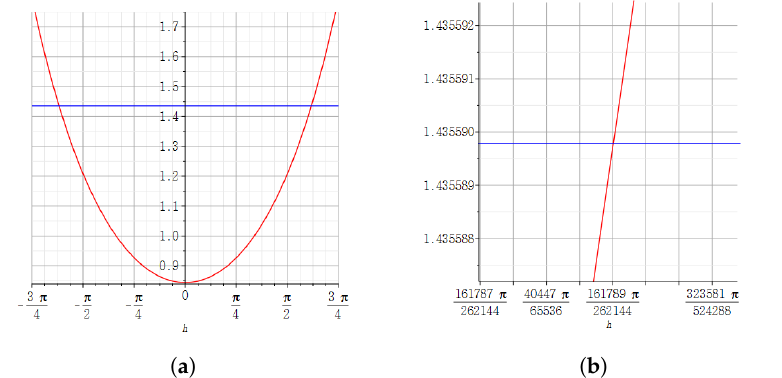
Figure 3. ( a ) Graph showing the absolute value of the quaternion j -step derivative of cos ( z ) at z 0 according to the step size h driven by the Maple program. ( b ) In the graph of ( a ), the result of zooming in about h near 5 π . In ( a , b ), the red graph represents the j -step derivative of cos z at z 0 8 according to the size of h , and the blue constant graph represents the absolute value of the derivative of cos z at z 0 by the definition of the derivative for a complex system.